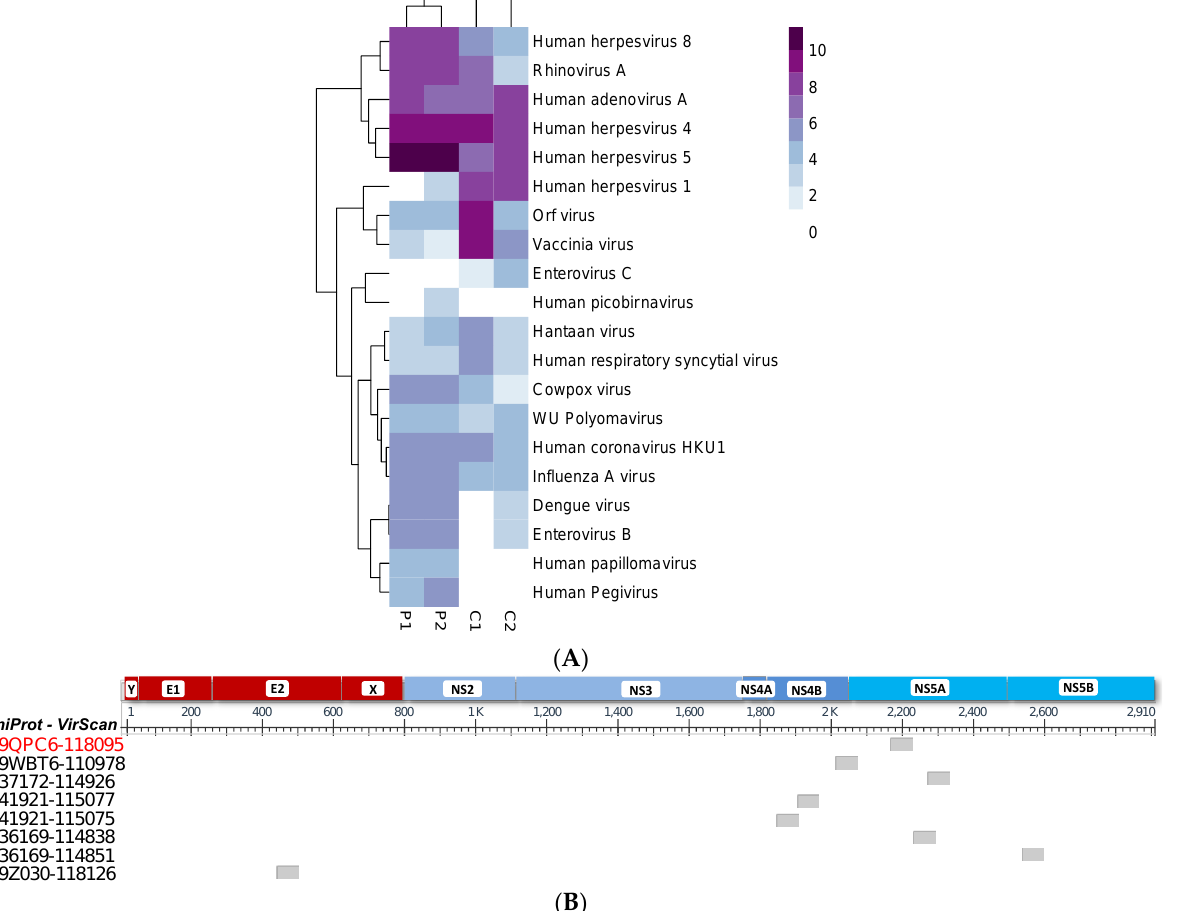
Figure 3. VirScan identified enriched anti-viral antibodies. ( A ) Heatmap with hierarchical clustering of the cumulative sum of significant peptide Epitope Binding Signal (EBS) in log 2 (gradient, 1.8 to 10) of each virus species in the two pregnancies and two unrelated healthy adult volunteers (Control, C). Absence of antibody is indicated in white. P1: First pregnancy; P2: Second pregnancy. ( B ) Alignment positions of the peptide that passed through all our filtering (red text) and the other peptides (black text) are denoted by grey boxes. The row labels indicate the identifier from the VirScan library and consist of a UniProt entry ID and a VirScan peptide ID. Each peptide is aligned to the different portion of the polyprotein represented at the top of the figure by red and blue boxes, and the amino acid position is denoted just below.